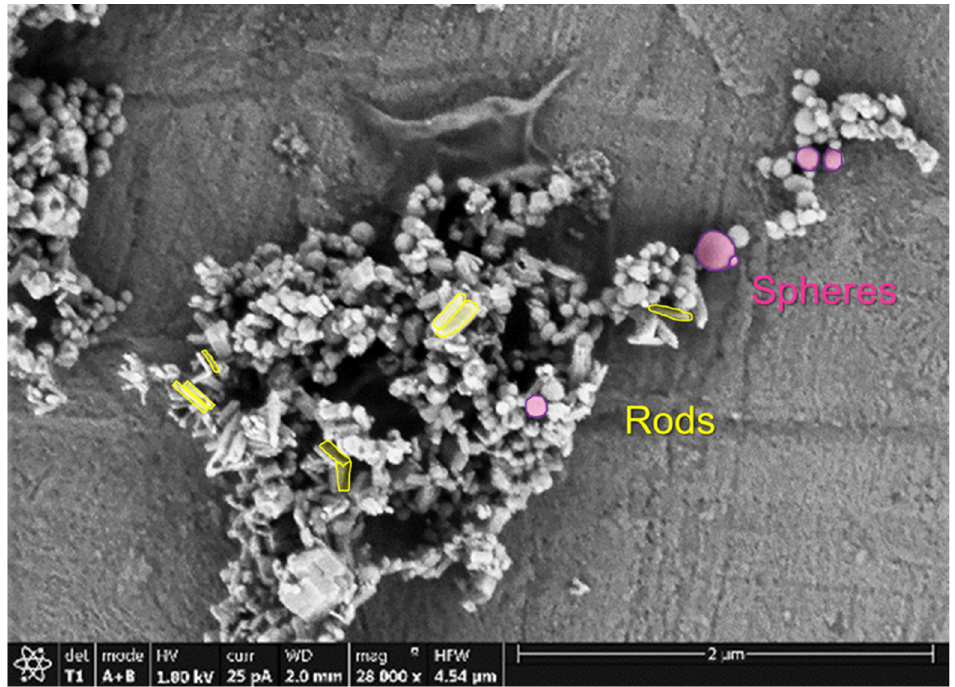
Figure 1. SEM micrographs of the commercial particles of hydroxyapatite (HA) observed at 28,000×.